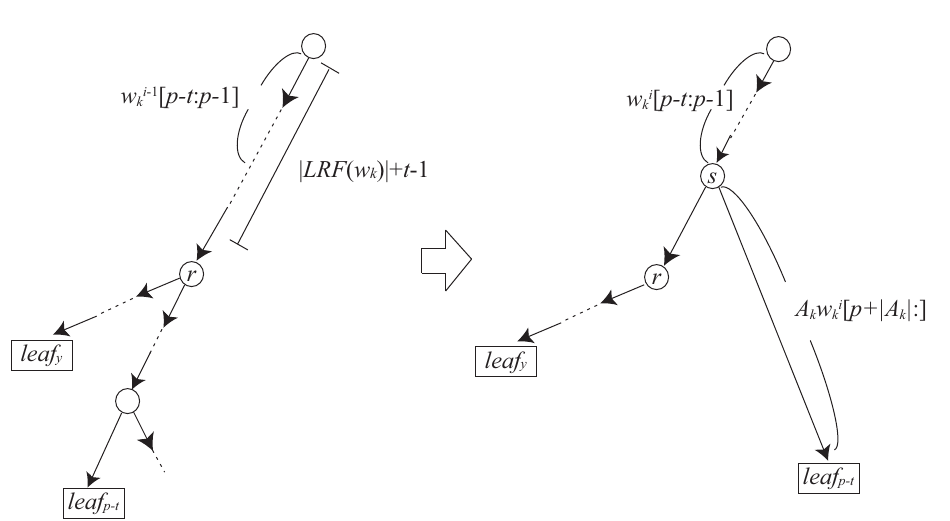
Figure 5. Illustration of Case 2 of Lemma